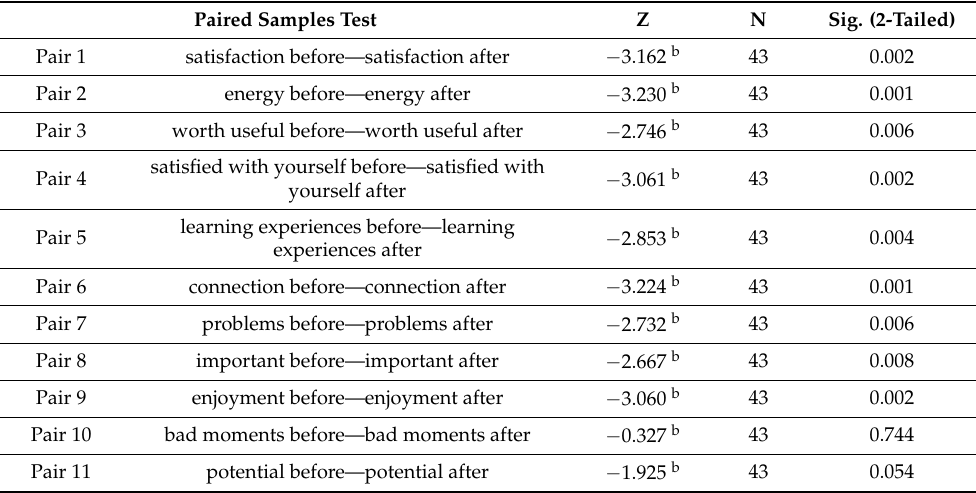
Table 6. Pemberton happiness index PHI I before and after the forest therapy experience—display of paired samples.